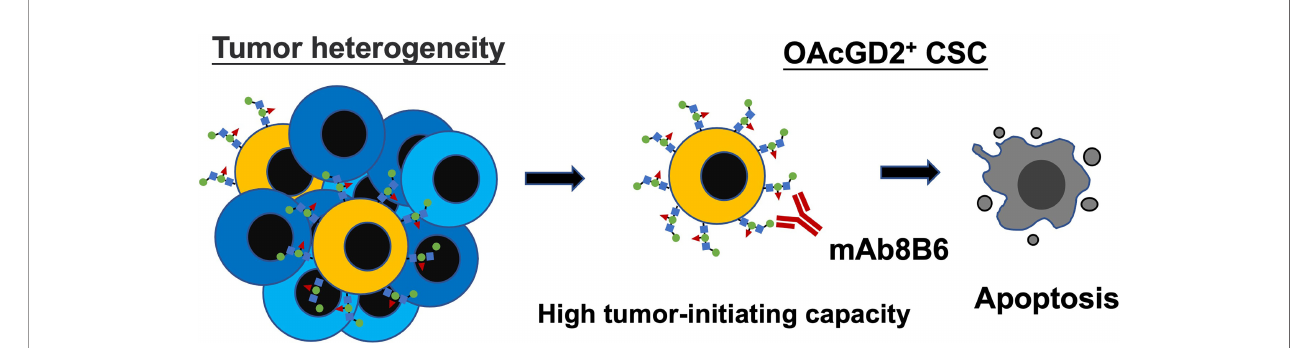
FIGURE 5 | Graphical abstract showing OAcGD2 as a novel marker for CSC which can be targeted with mAb8B6 to suppress tumor growth by